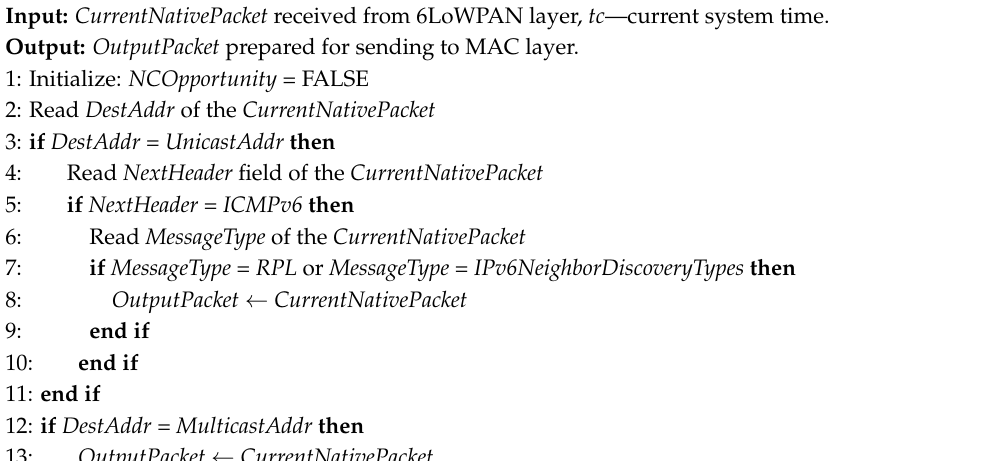
Algorithm 1. Encoding Procedure at the NC